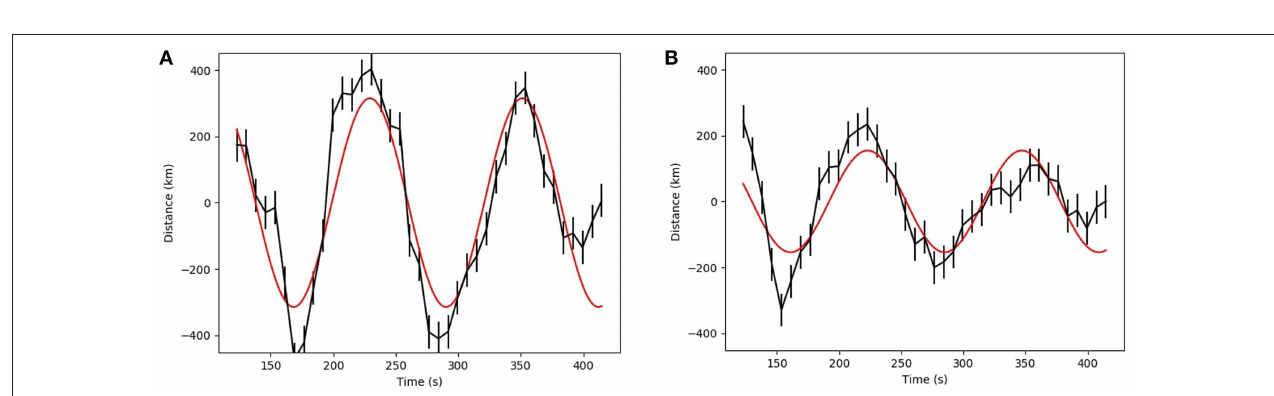
FIGURE 5 | (A) A typical example of a ROSA H α fibril taken at t 399.36 s from the start of the observational window. The middle slit is placed perpendicular to the = fibril. The mean of the intensities along the middle slit and two parallel slits at a pixel each side at each time step is plotted in (B) . The white dots correspond to the boundaries of the fibril, calculated as the position of half-maximum of the fitted Gaussian. Axis values are in units from the bottom left of the observational domain.